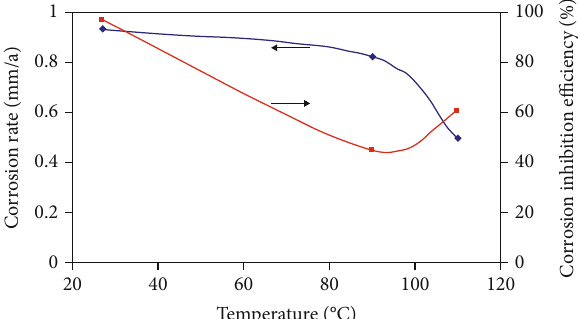
Figure 6: Curve of temperature with corrosion rate under modi fi ed sacri fi cial anode